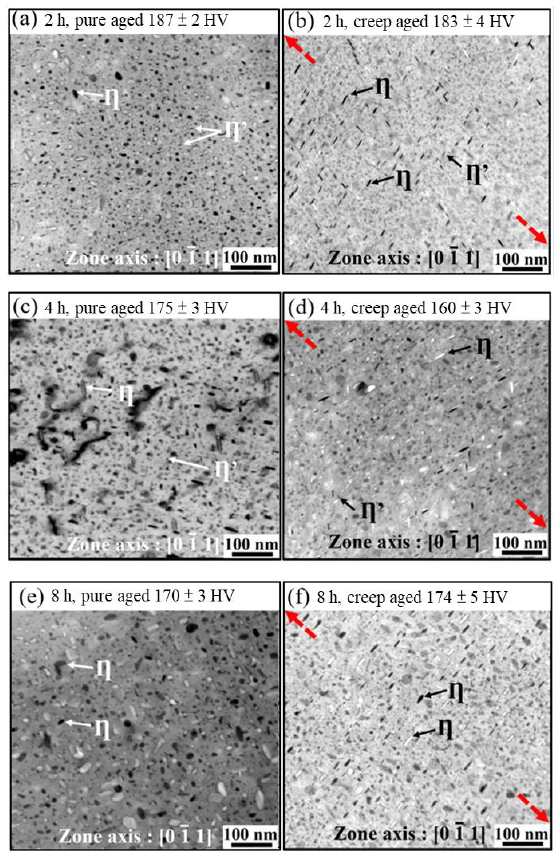
Figure 7. TEM images and the corresponding Vickers hardness number of pure/creep aged specimens for ( a , b ) 2 h, ( c , d ) 4 h, ( e , f ) 8 h (Red arrows show the direction of stress applied).